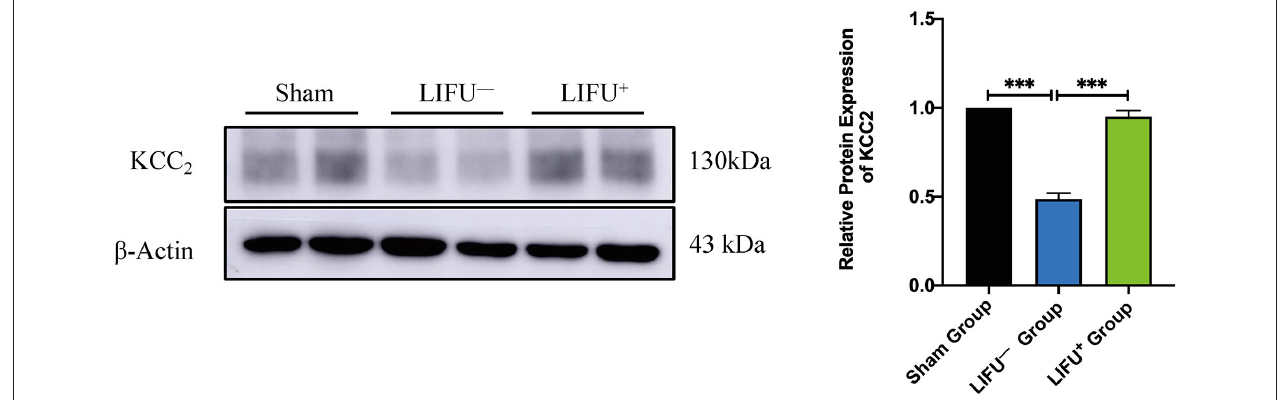
FIGURE 5 | Protein expression of KCC 2 in the sham group, LIFU − group, and LIFU + group after 4 weeks of LIFU treatment. Western blot (WB) showing the expression of KCC 2 ; histogram showing the intensity of protein expression for the different groups. These result show that the intensity of KCC 2 expression significantly decreased following SCI (*** P < 0.001, compared with the sham group; one-way ANOVA with LSD test; n = 5, mean ± SEM); following LIFU treatment, the intensity of KCC 2 expression significantly increased (*** P < 0.001, compared with the LIFU − group; one-way ANOVA with LSD test; n = 5, mean ±